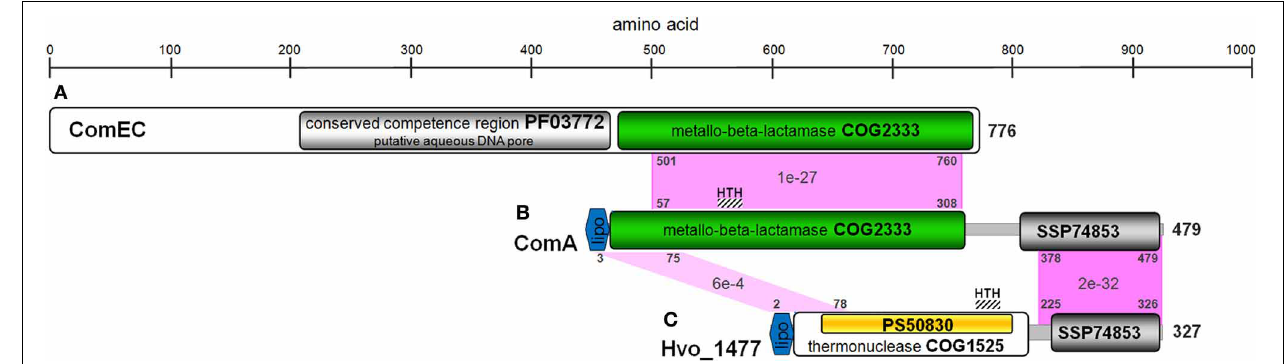
FIGURE 8 | Protein sequence and domain structure similarity of B. subtilis ComEC, Halobacterium sp. NRC-1 ComA, and H. volcanii Hvo_1477. Homologous regions between proteins are shown in pink